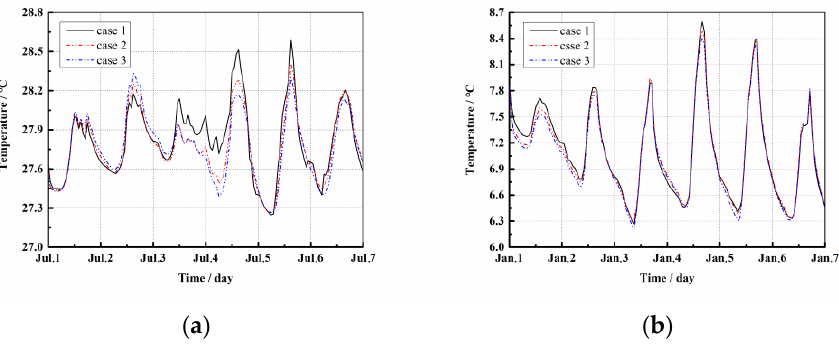
Figure 13. The indoor air temperature of rammed earth folk house: ( a ) in summer; ( b ) in winter.